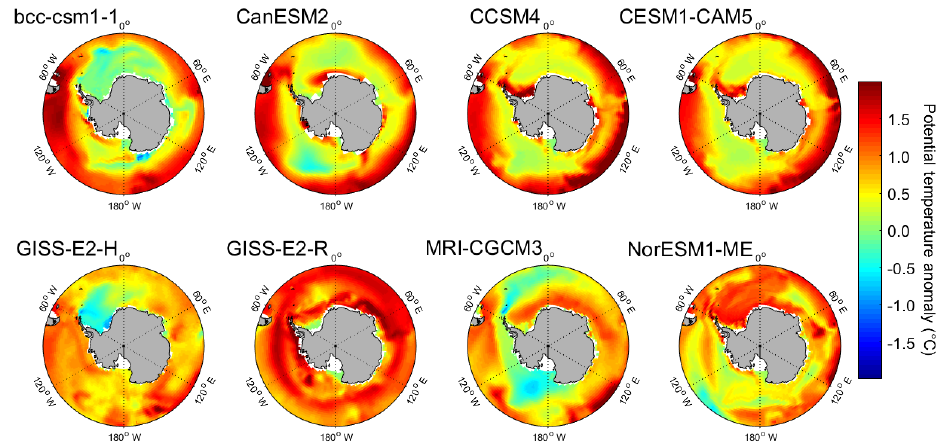
Figure 3. Projected Southern Ocean temperature anomalies in 2100 (2091–2100 mean), averaged over 400–700m depth range, under RCP8.5 relative to the 2006–2016 mean for each of the CMIP5 AOGCM subset